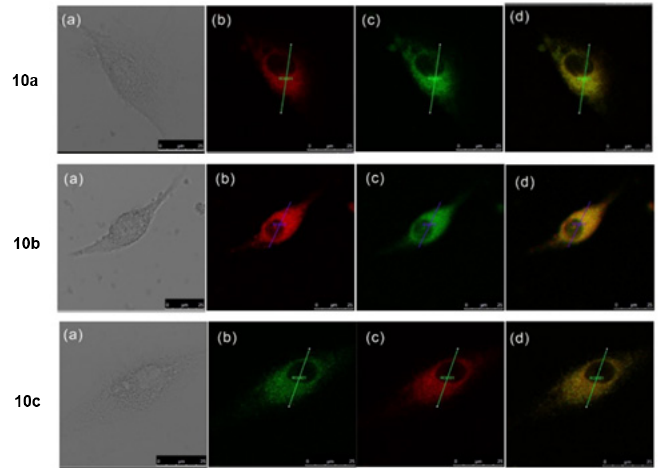
Figure 10. Confocal fluorescence images of HeLa cells stained with probes 10a – c . ( a ) Bright field images, ( b ) rows 1 and 2: probe 10a – b fluorescence under a red channel, row 3: probe 10c fluores- cence under a green channel, ( c ) rows 1 and 2: MitoTracker Green FM fluorescence under a green channel, row 3: MitoTracker Red CMXRos fluorescence under a red channel. ( d ) Merged images. Adapted from